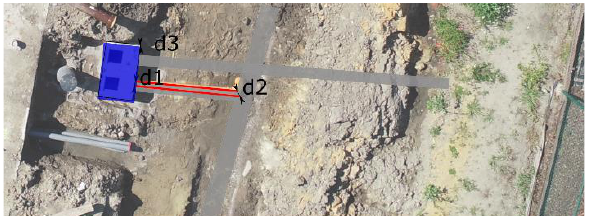
Figure 7. Detail of one of the connections where the differences between the EP MIB and the manual detected objects are visible.